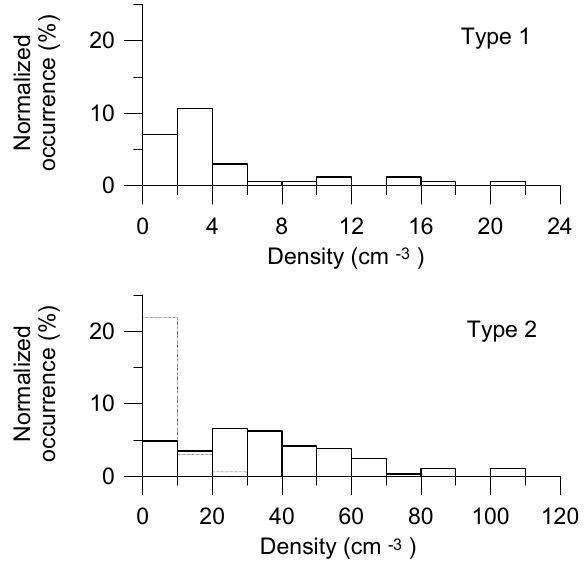
Fig. 7. Distribution of localised proton flux observations as a func- tion of the cold plasma density at geosynchronous orbit. Upper panel: Normalised distribution of the Type 1 events. Bottom panel: Normalised distribution of the Type 2 events (solid line). For com- parison the dashed line reproduces the Type 1 events distribution. Note the different scale on the plasma density axes in upper and bottom